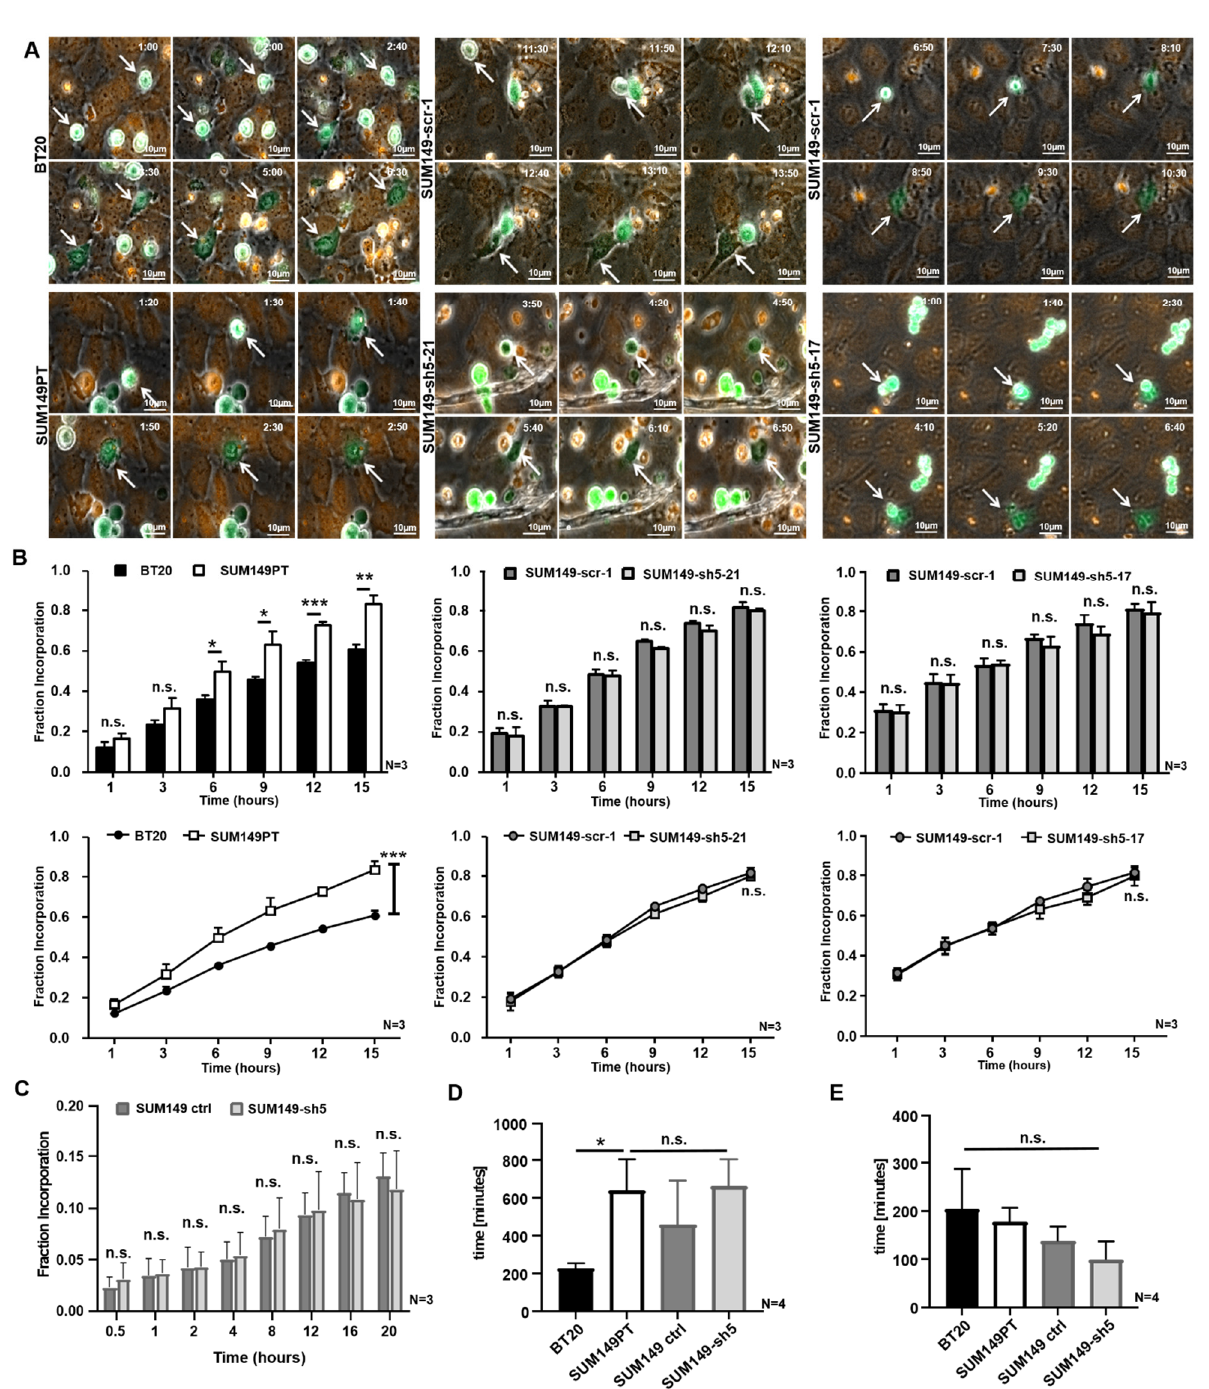
Figure 3. The incorporation of SUM149 cells into the HUVEC monolayer is VE-cadherin independent. 50,000 tumor cells (green) were stained with CellTracker Green and placed on a confluent HUVEC monolayer (orange), fluorescently labeled with CellTracker Orange. The incorporation was recorded over 15 h with a microscope focused on the HUVEC monolayer. ( A ) The BT20, SUM149PT, SUM149-scr-1, SUM149-sh5-21 and SUM149-sh5-17 cells (white arrows) moved into the focus plane of HUVEC and incorporated into the endothelium. 40x magnification. Time in h:min after the beginning of the experiment is indicated; ( B ) Fraction of Incorporation at 1, 3, 6, 9, 12 or 15 h after the start of experiment; ( C ) 20,000 tumor cells were placed on a HUVEC monolayer, and their incorporation was recorded over 20 h with microscope focus on the HUVEC plane. Fraction of Incorporation 0.5, 1, 2, 4, 8, 12, 16 and 20 h after the start of the experiment; ( D ) Incorporation inception times do not depend on VE-cadherin as analyzed by live cell imaging ( E ) Duration of incorporation is VE-cadherin independent as calculated by live cell imaging. Bars represent standard deviation; n.s. not significant, * p ≤ 0.05; ** p ≤ 0.01; *** p ≤ 0.001; statistical analysis was conducted using one-way and two-way ANOVA.